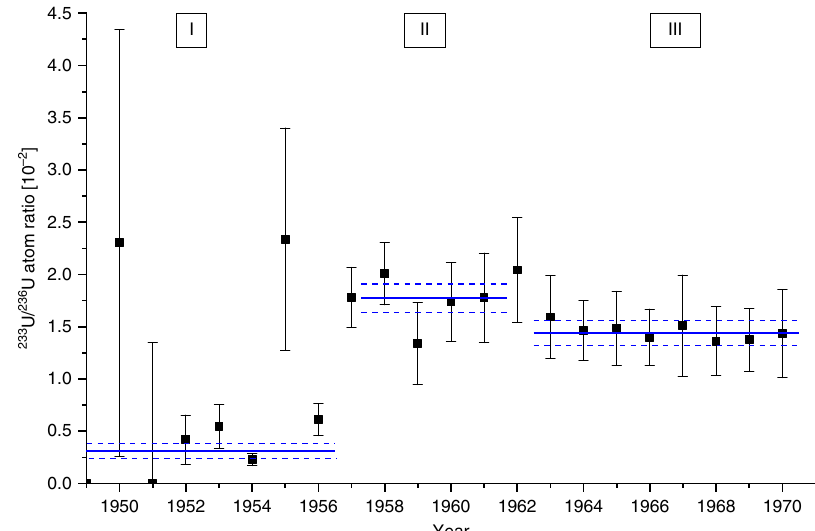
Fig. 3 233 U/ 236 U ratio in coral samples. 233 U/ 236 U (black squares) calculated from the measurement results for the Kume coral core with ±1 σ uncertainty. The solid blue lines indicate the weighted average for the respective time period (I – III) and the dashed lines the corresponding 1 σ uncertainty (s.e.m.).